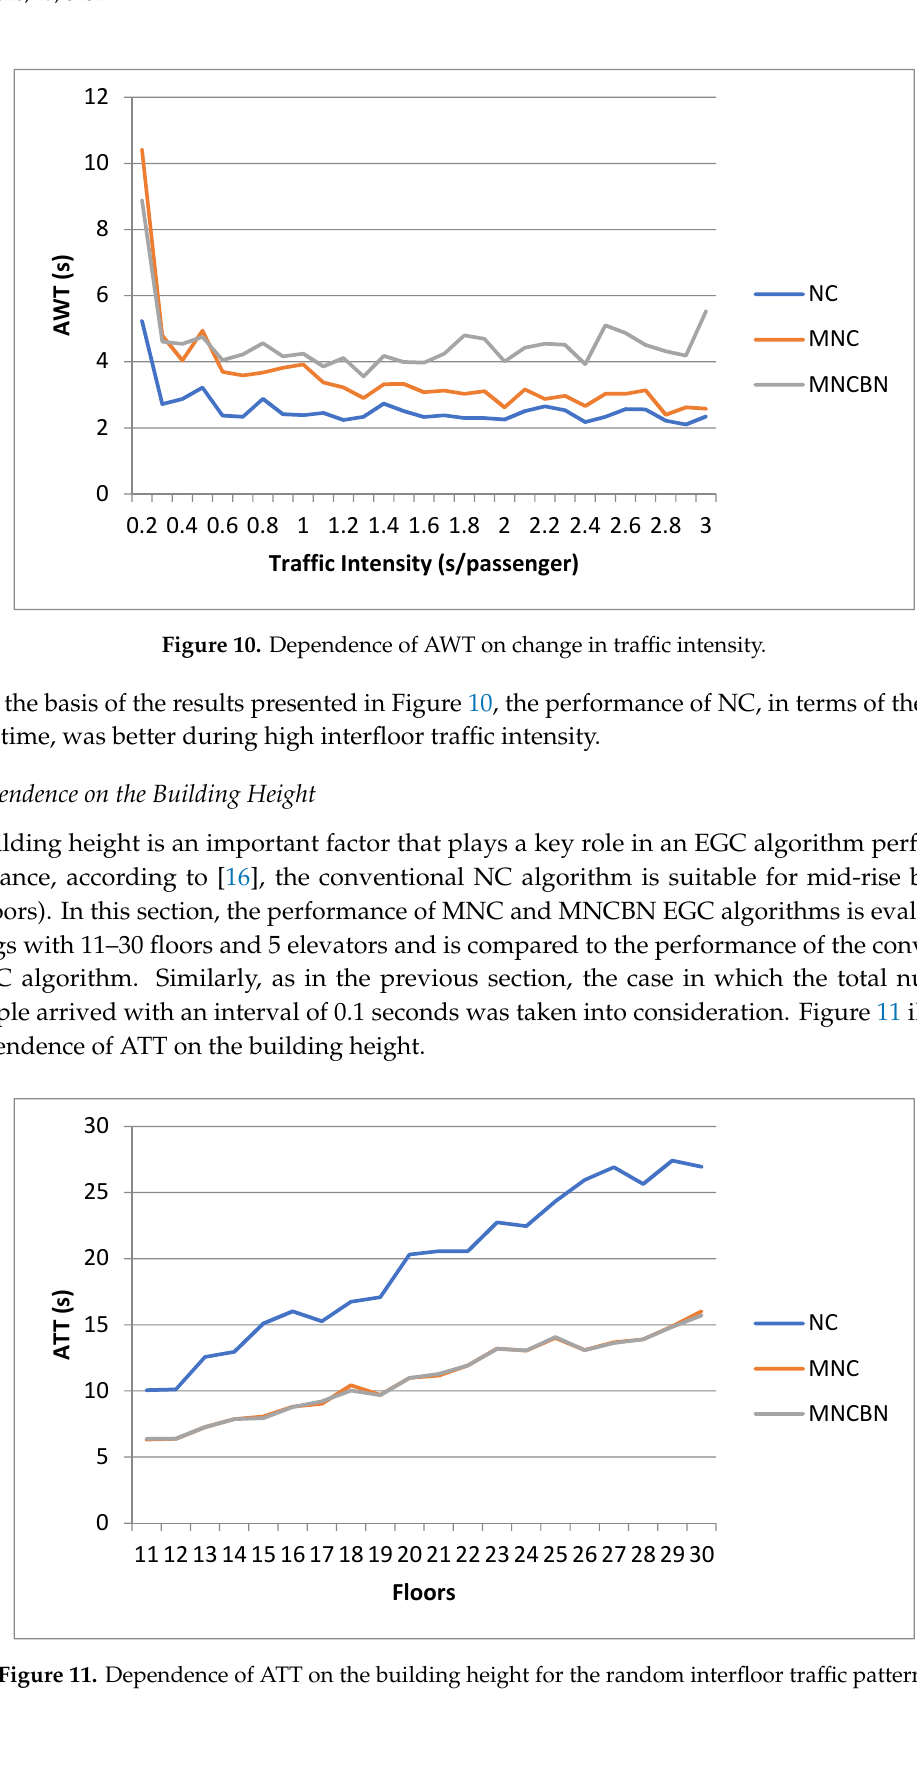
Figure 9. Dependence of AJT on change in traffic intensity.